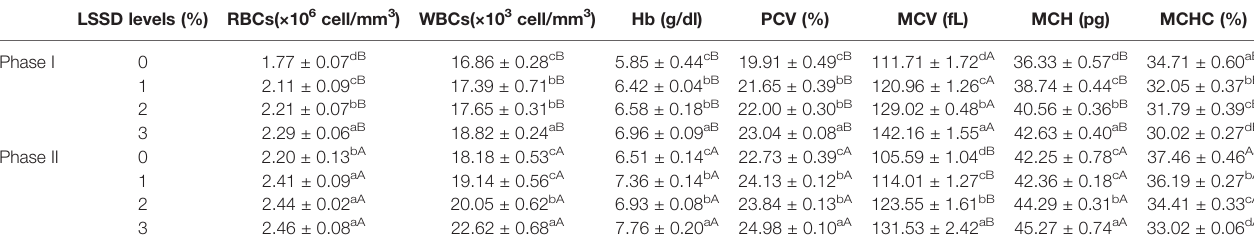
TABLE 5 | Hematological indices of O. niloticus fed 0, 1, 2, and 3% diet of L. siceraria seeds supplemented diets (LSSD) for 60 days (Phase I) and after exposure to A. hydrophila (Phase II).